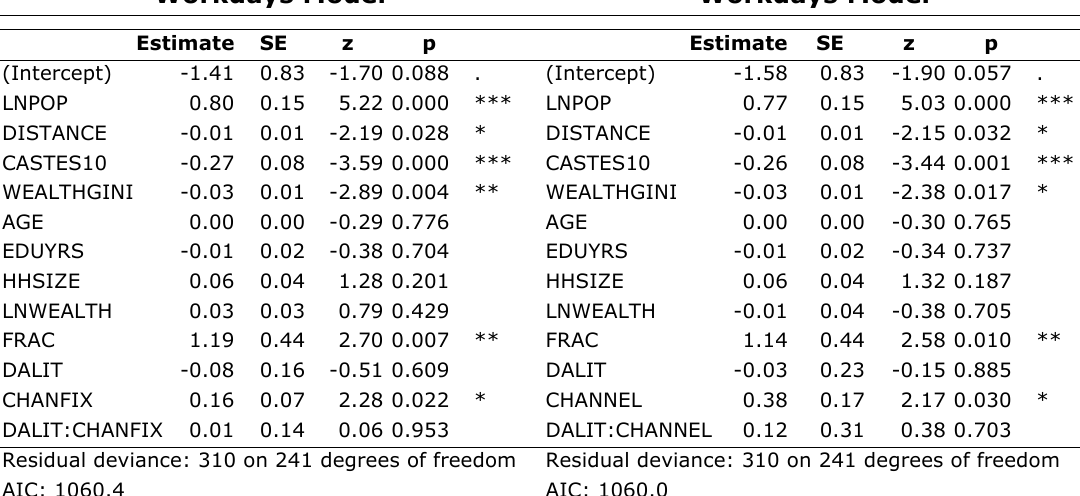
Table A 8. CHANNEL-inequality-adjusted workdays regression comparison. Workdays negative binomial regression replicated with (a) and without (b) adjusted channel variable. CHANFIX is the inequality-adjusted version of the CHANNEL variable, ie the residuals of the AIC best fit model explaining CHANNEL distribution. Note that the changes in estimates and probabilities are small, and that CHANFIX remains and important explanatory factor, even when the embedded aspects of social inequality are removed. Other CHANNEL-inequality-adjusted regressions showed similar